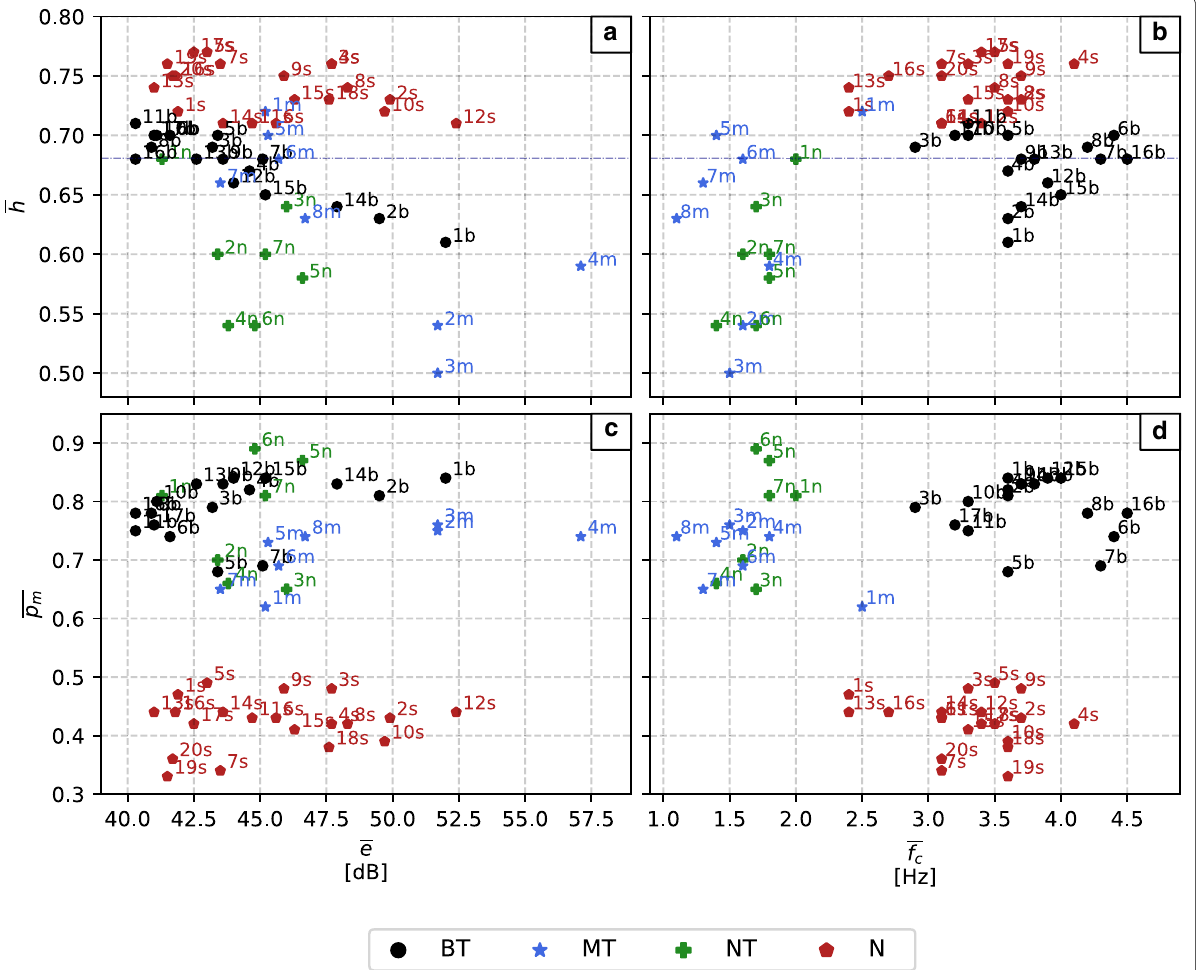
Fig. 4 Comparison of the 52 long-duration events. Comparison of the 52 long-duration events. Permutation entropy versus energy ( a ) and centroid frequency ( b ), and dominant polarization degree versus energy ( c ) and centroid frequency ( d ). The blue dashed line in a and b depicts the background level of the permutation entropy. For detailed information of each event see Additional file